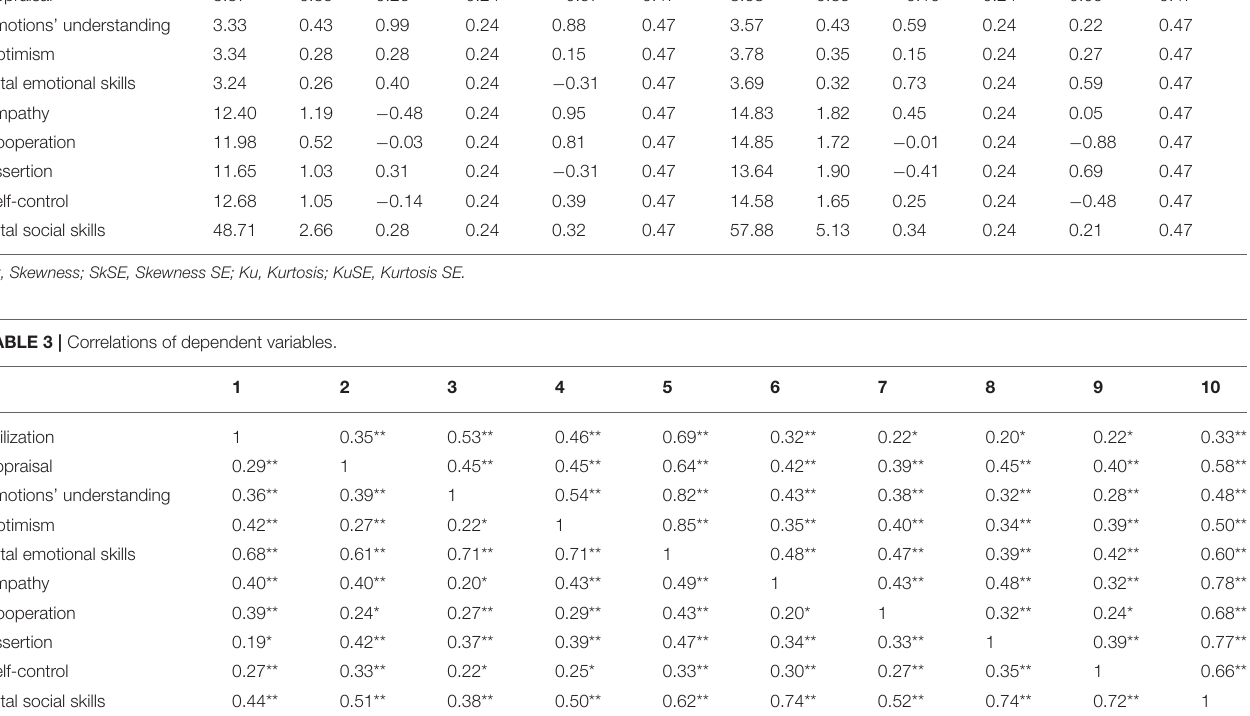
Before experiment